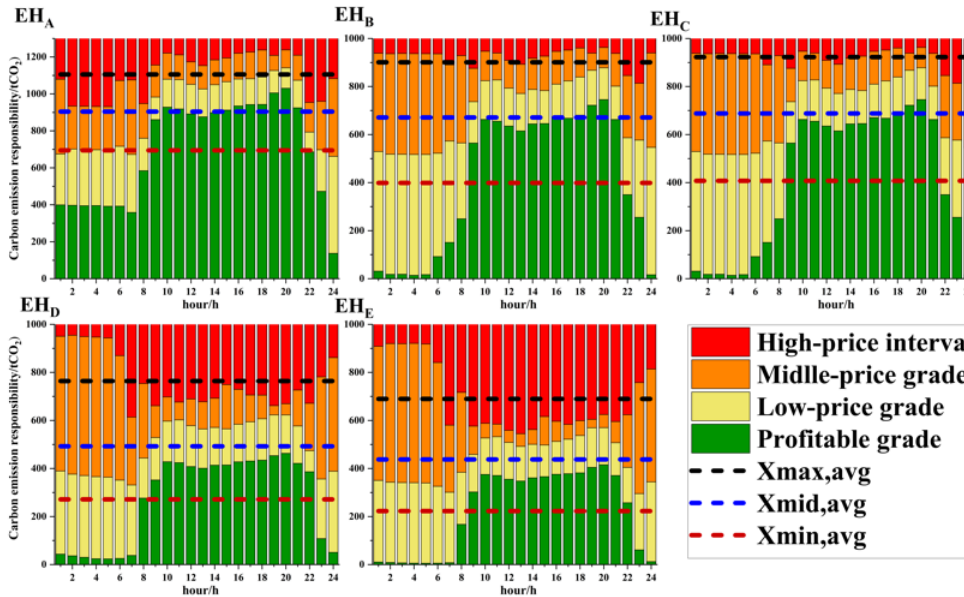
Figure 6. The carbon emission responsibility grades of each EH allocated by the Shapley value method in the scenario with wind